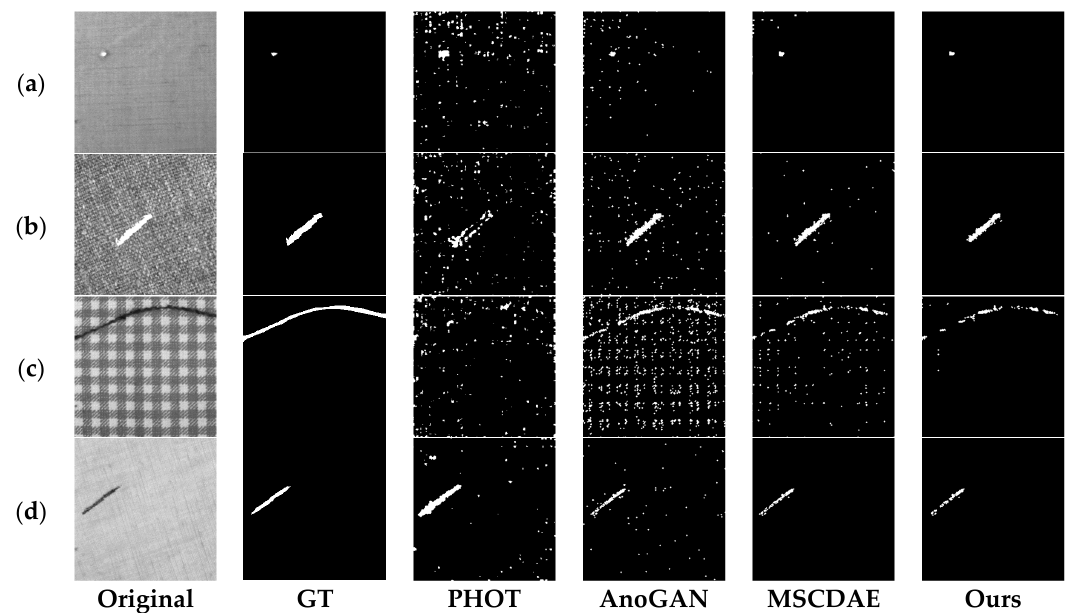
Figure 7. Segmentation results of defective samples with four kinds of textural background from TILDA Textile Texture dataset under different methods. Each row from left to right are original defect image, ground truth image, results derived from PHOT, AnoGAN, MSCDAE, and our methods. ( a ) c1; ( b ) c2; ( c ) c3; ( d ) c5.